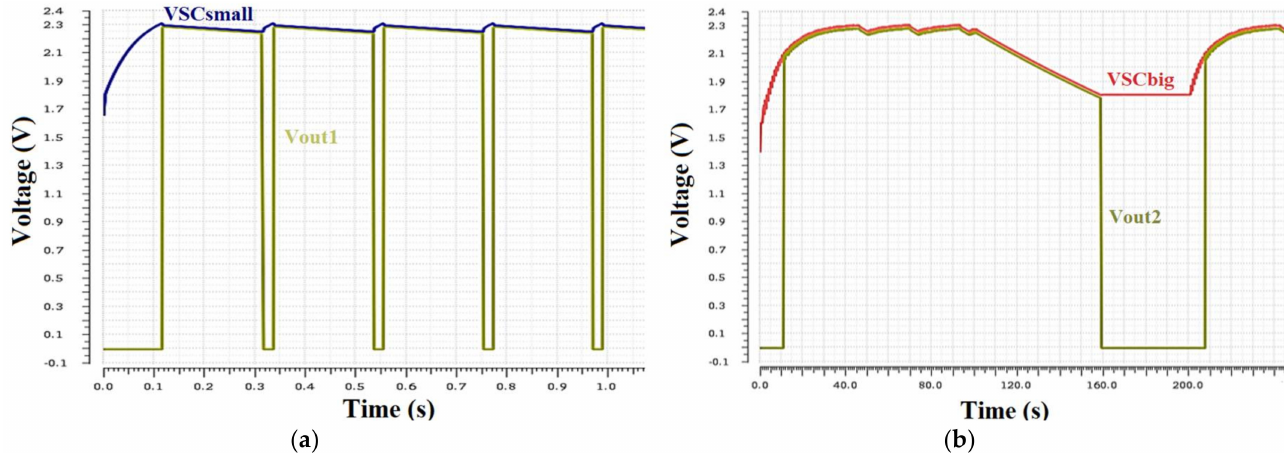
Figure 6. Connection of the external loads according to the predefined voltage thresholds of the supercapacitors. The output loads are disconnected in low-input energy conditions to preserve the operation of the system. ( a ) SCsmall voltage level and Vout1 load output. ( b ) SCbig voltage and Vout2 load output.